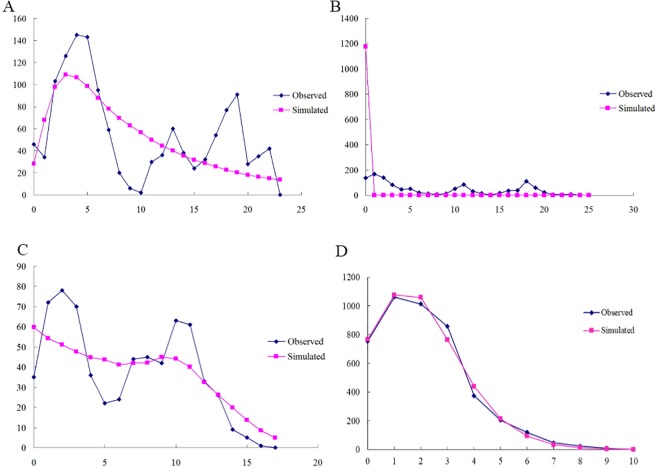
Observed and simulated mismatch distributions of entire samples.Sequence data are shown for (A) COI; (B) COII; (C) Cytb and (D) ITS2 region. The horizontal axis represents the number of pairwise differences, and the vertical axis shows relative frequency.